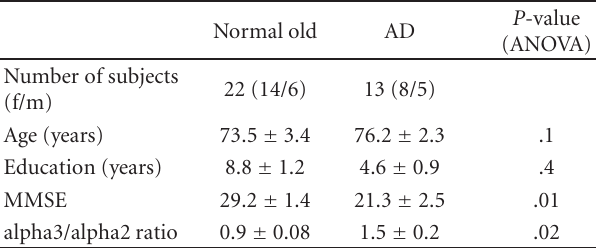
Table 1: ANOVA results of demographic variables, that is, age, education, MMSE score, and neurophysiological EEG markers, that is alpha3/alpha2 ratio (see text for